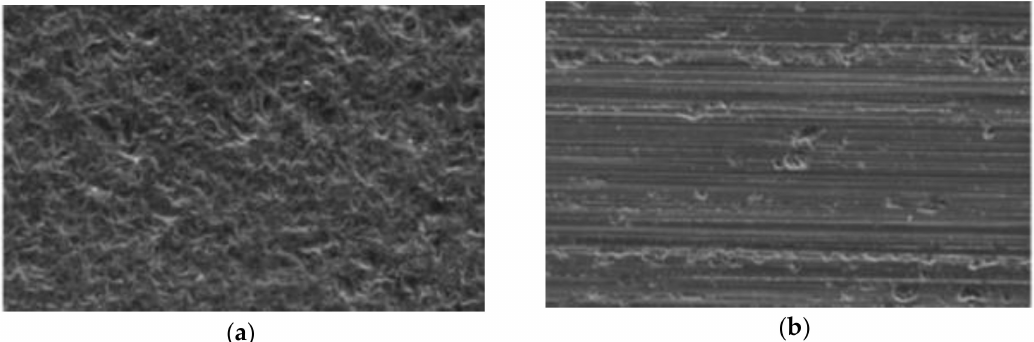
Figure 2. The SEM images of silicon wafer surfaces formed by silicon carbide particle suspension cutting ( a ) and diamond wire cutting ( b